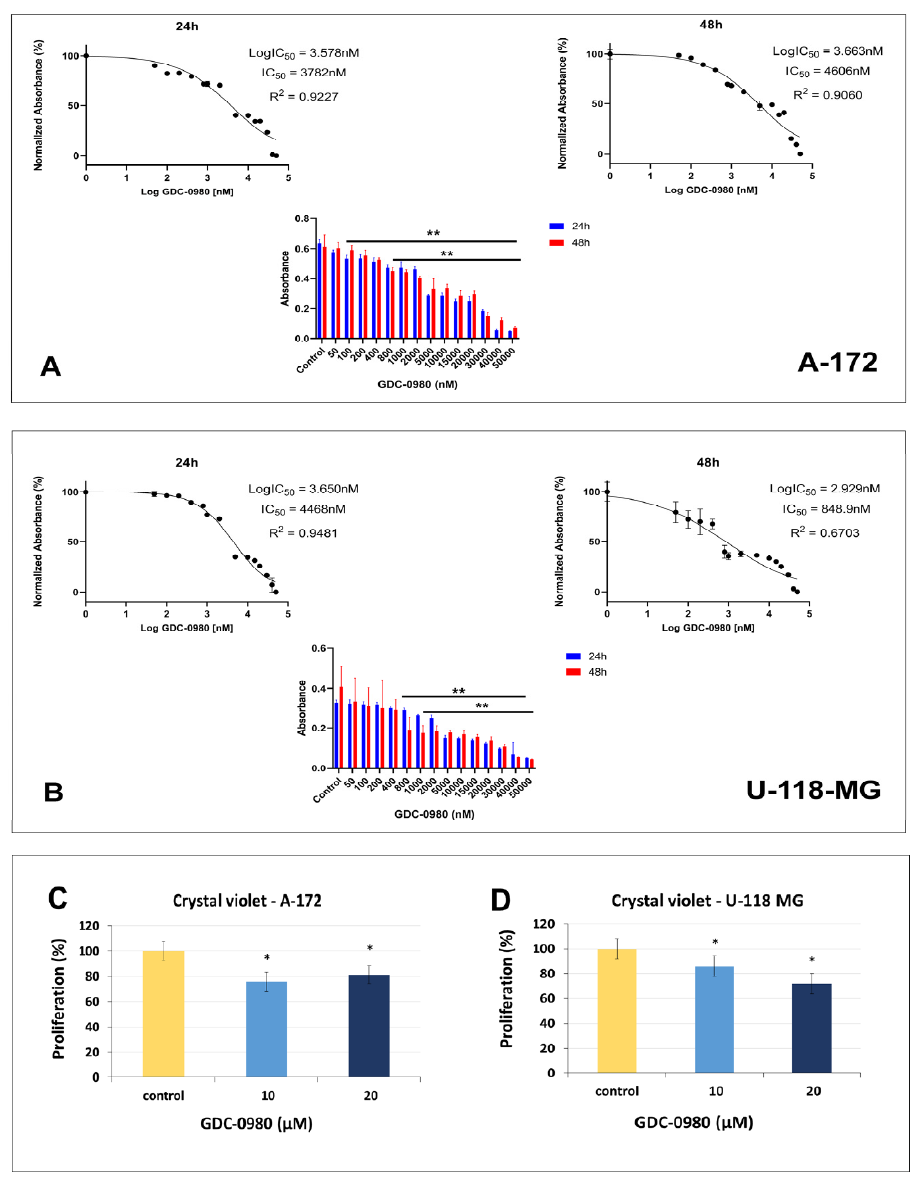
Figure 3. The viability of A-172 ( A ) and U-118-MG ( B ) glioblastoma cell lines treated with different concentrations of GDC-0980 ranging from 50 to 50,000 nM ( A , B ) and the crystal violet assay analysis for the proliferation of A-172 ( C ) and U-118-MG ( D ) cells treated with 10 and 20 µ M concentrations of GDC-0980 for 24 and 48 h. Mean values from three independent experiments ± SD are presented. Note: significant alterations are marked with asterisks: * p < 0.05; ** p < 0.01. Statistical significance was considered if p <